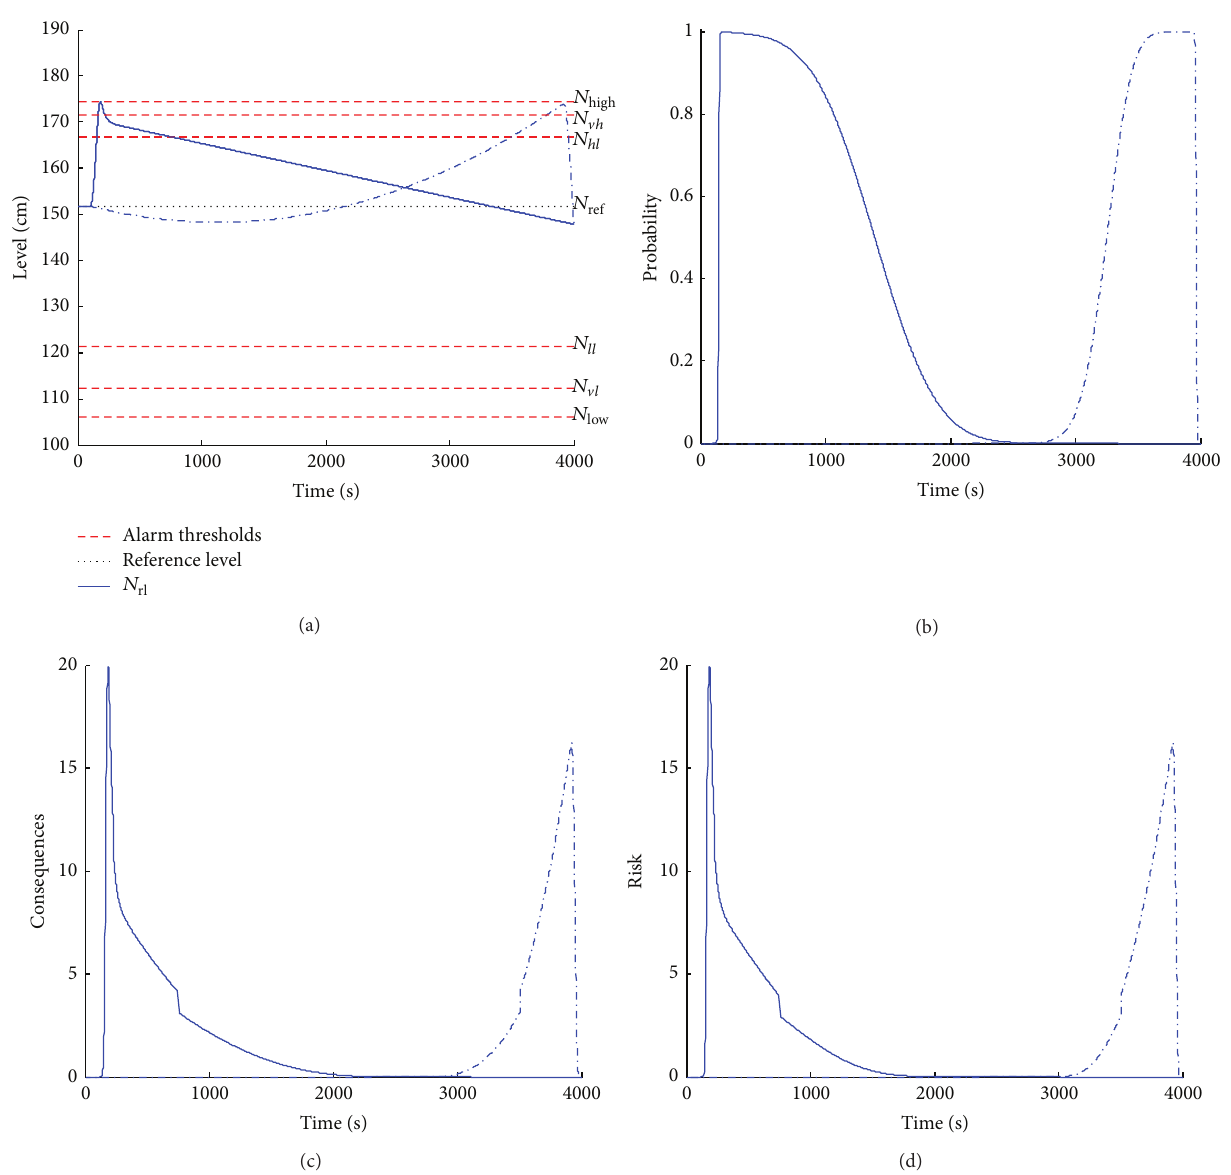
Figure 11: Probability 𝑝(𝑡) , consequences 𝑐(𝑡) , and risk 𝑟(𝑡) for two sequences of